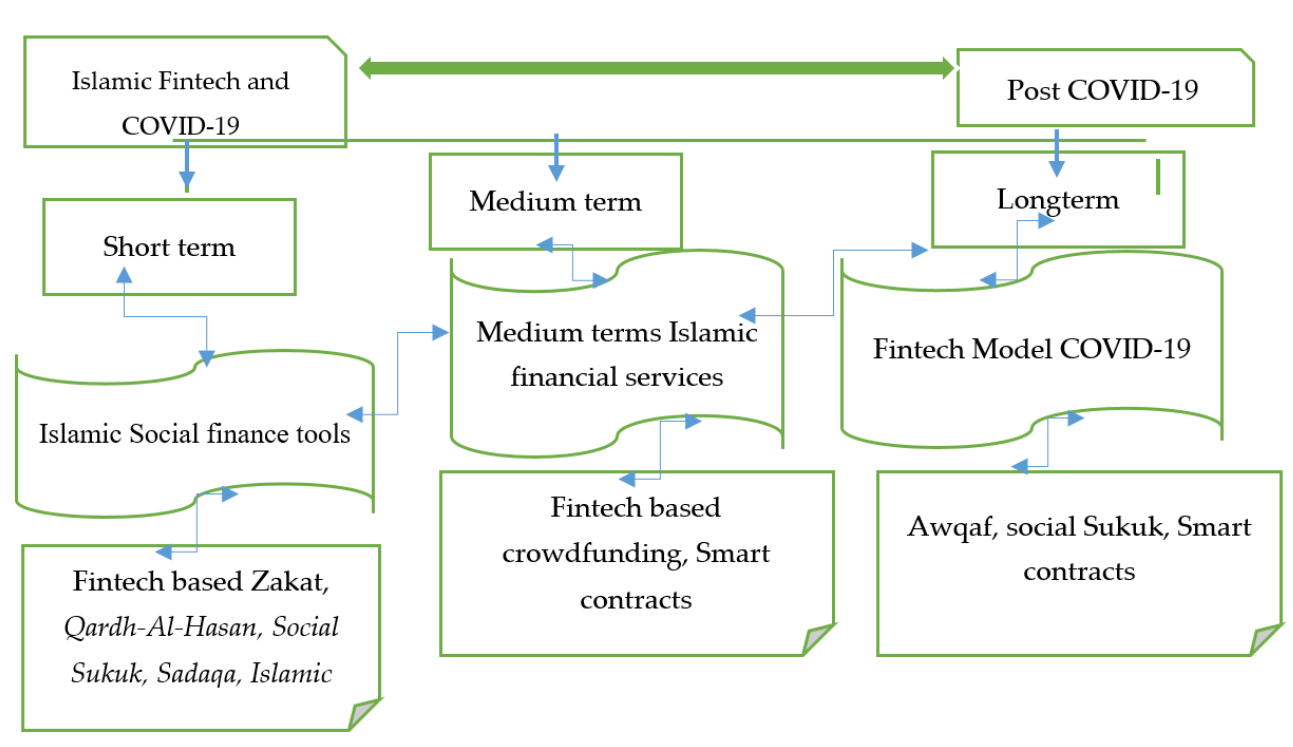
Figure 3. Research Framework.